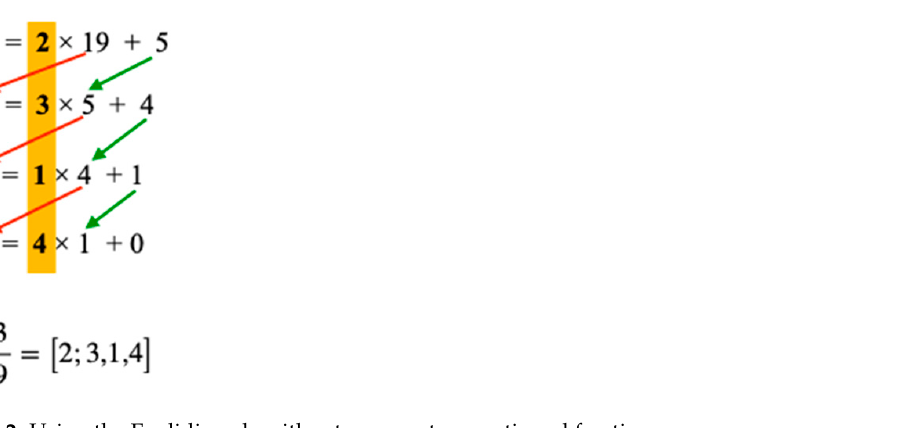
Figure 2. Using the Euclidian algorithm to compute a continued fraction.